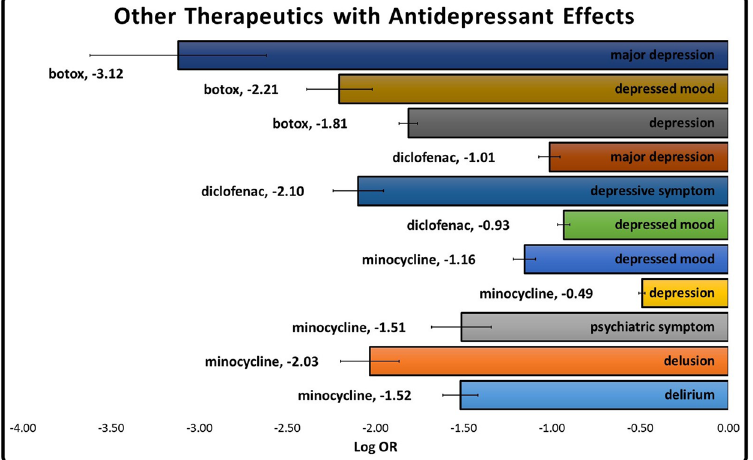
Figure 2. LogOR of psychiatric events were calculated from FAERS patients who used botox, diclofenac or minocycline. FAERS patients who took any drugs for the indication of depression were used as the control cohort. Negative values showing protective